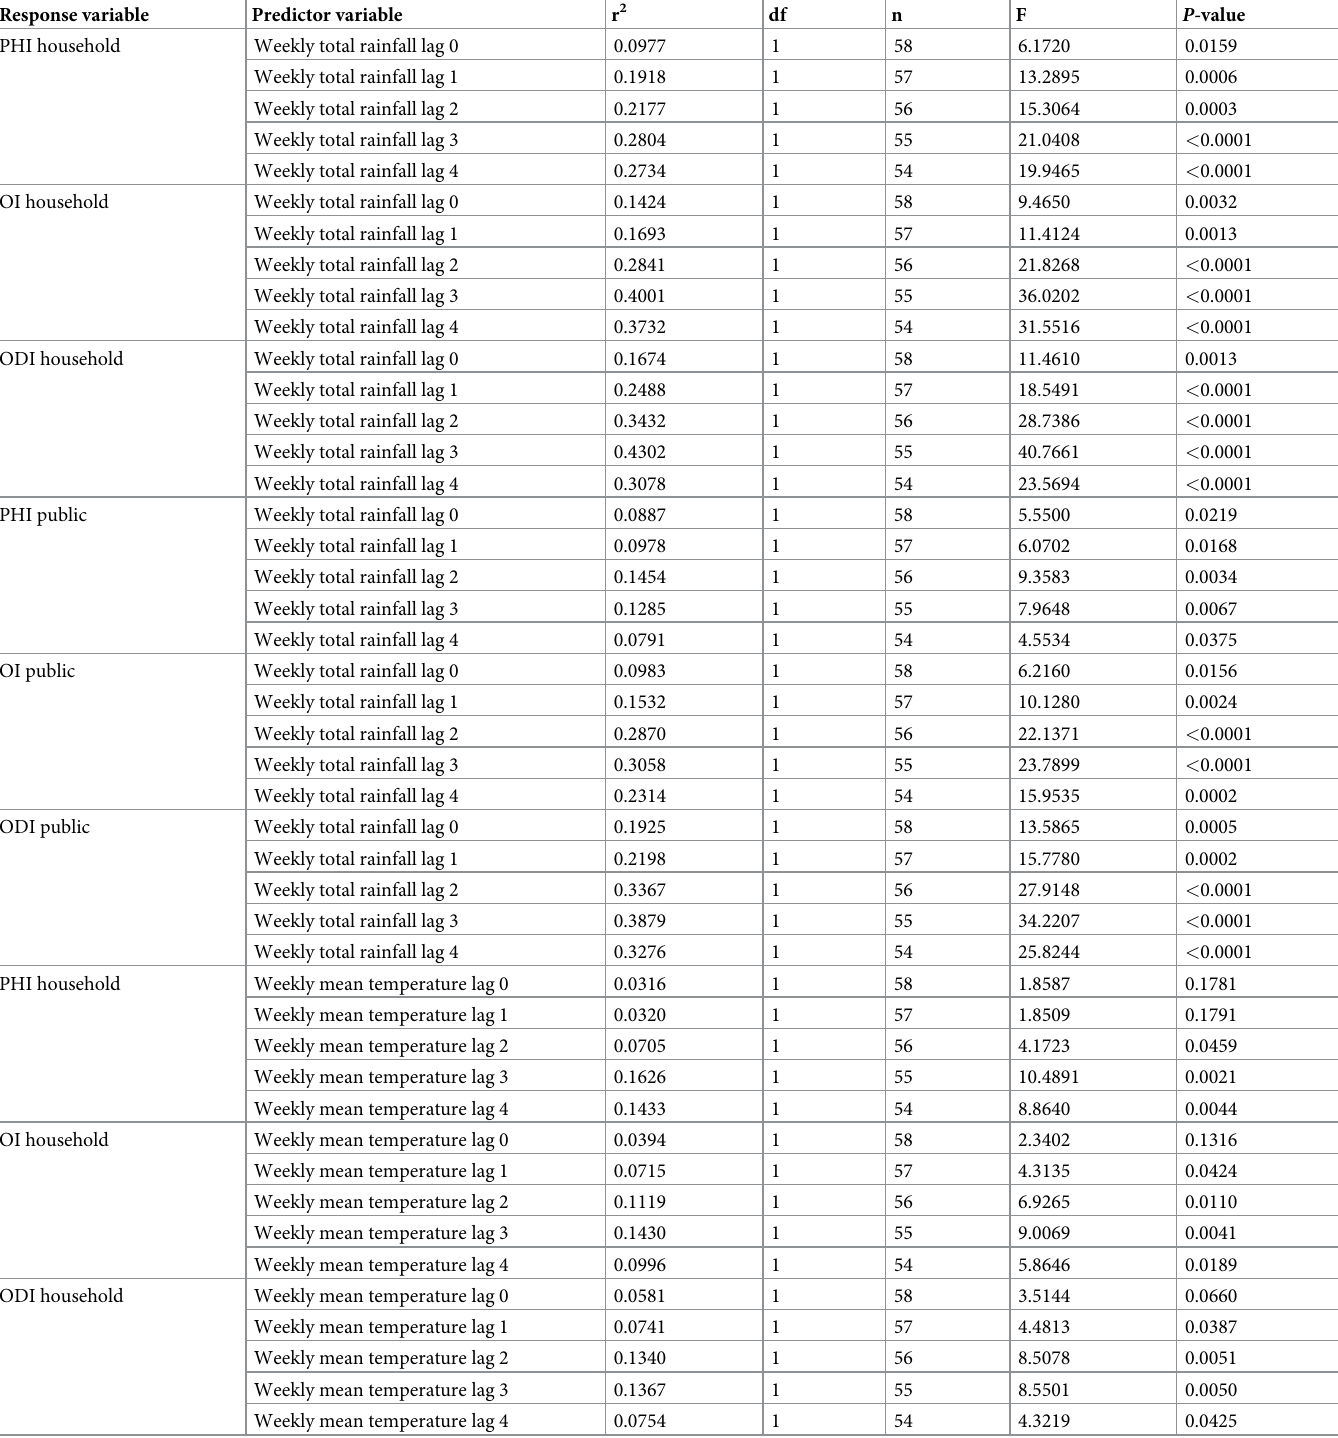
Table 4. Regression analysis of weekly total rainfall and mean temperature at 0–4-week lag periods in relation to vector indices of households and public areas. Response